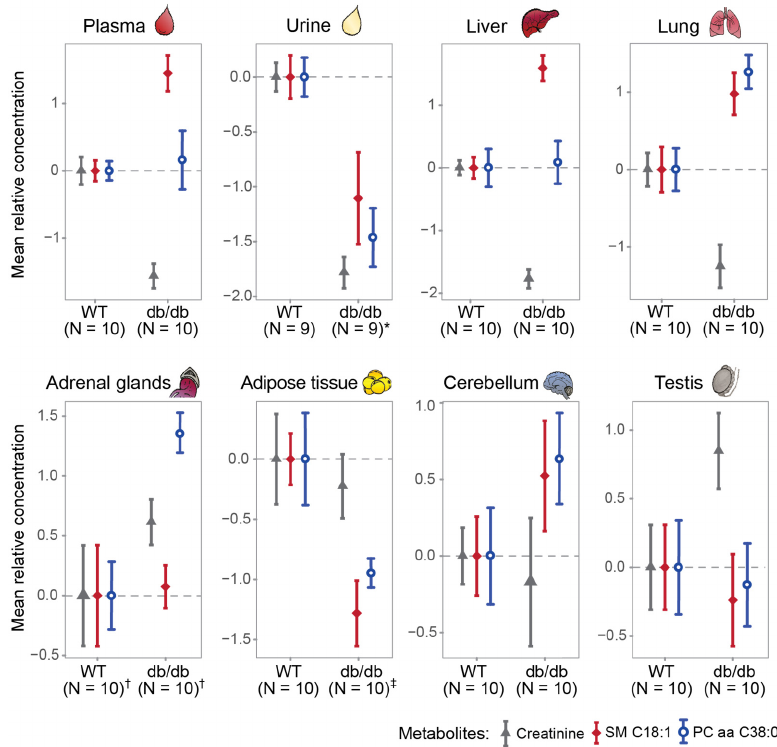
Figure 2. Analysis of creatinine and two candidate metabolites in murine biofluids and tissues. Mean relative concentrations (with standard errors) of the metabolites (creatinine, SM C18:1, and PC aa C38:0) in murine plasma, urine, liver, lung, adrenal tissue, adipose tissue, cerebellum, and testis. * N = 7 in db/db for SM C18:1. † For creatinine, N = 9 in db/db, N = 9 in WT. ‡ N = 9 in db/db for creatinine. Abbreviations: db/db, leptin receptor-deficient mouse model; WT, wild type mice; SM, sphingomyelin; PC aa, phosphatidylcholine diacyl.